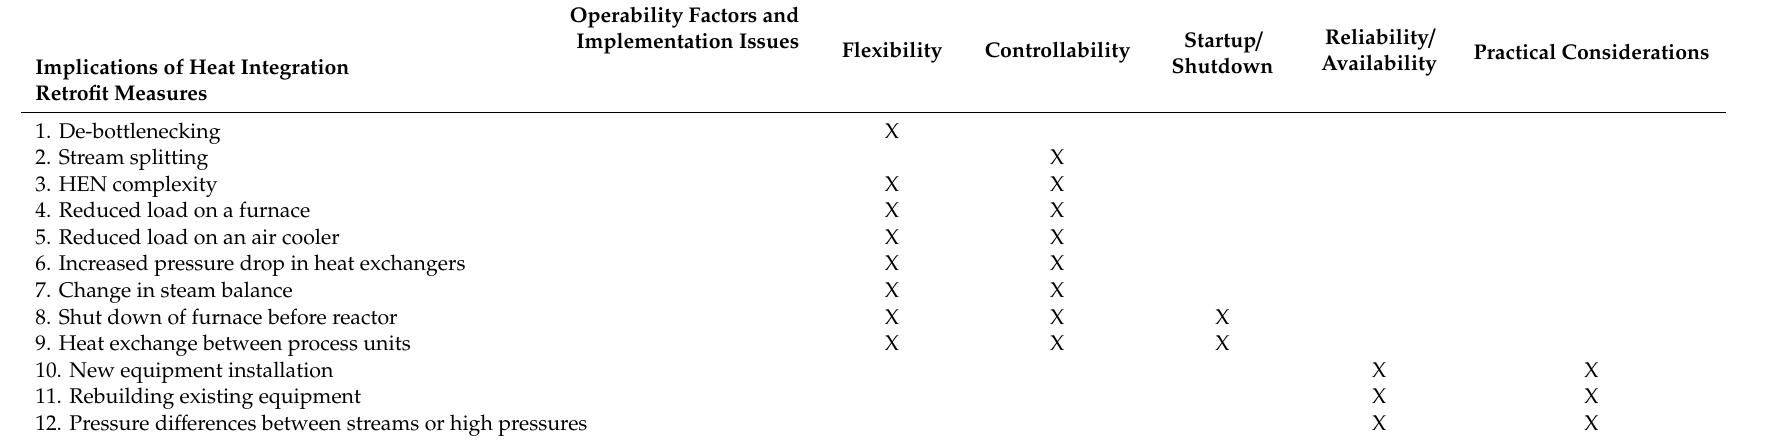
Table 1. The assumed relations between the process implications of heat integration retrofit measures and the most a ff ected operability factors and practical implementation issues (Marton et al.